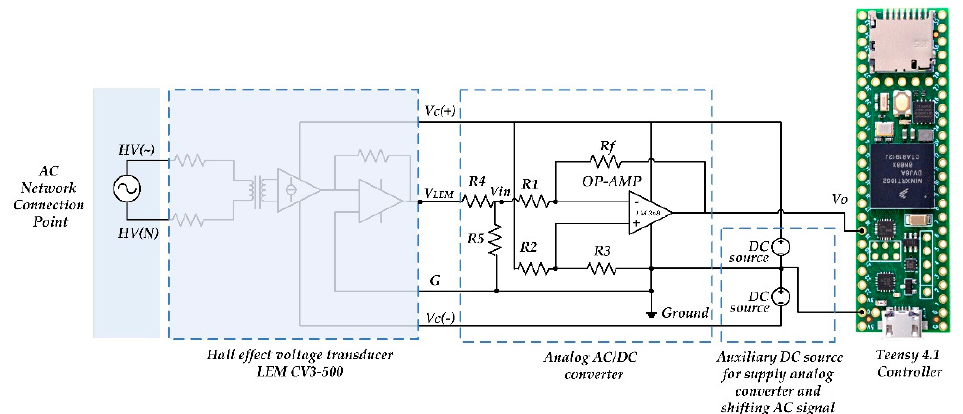
Figure 3. Principle scheme of the voltage transducer. For the first step from high to low voltage used the device LEM CV-3-300 [37].